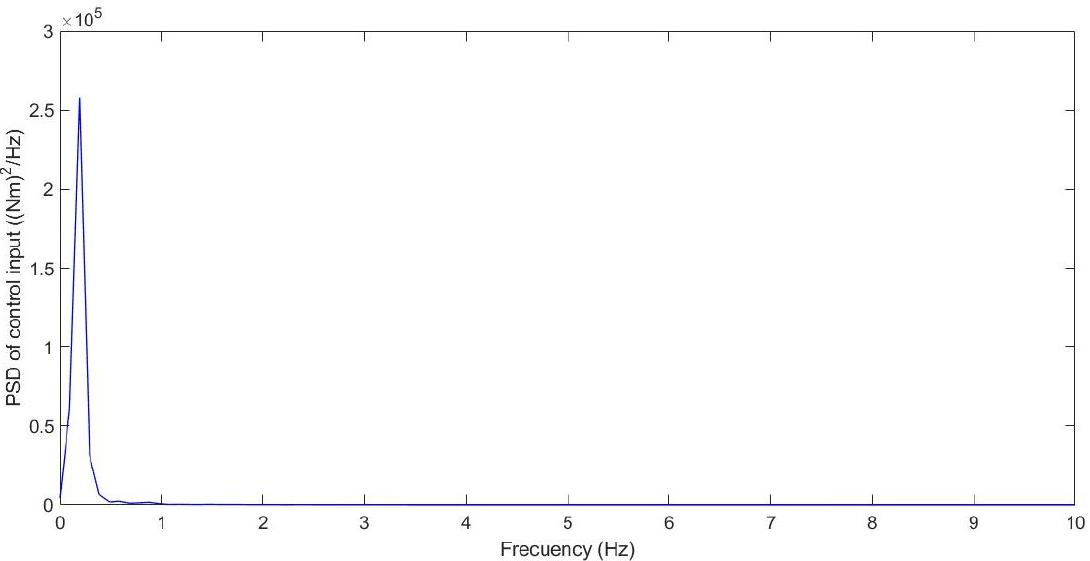
Figure 25. Frequency response for test 3: Roundabout at 120